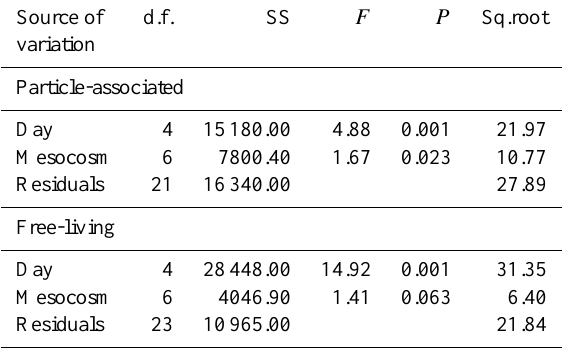
Table 2. Permutational multivariate analysis of variance (PER- MANOVA) on ARISA banding pattern (Bray–Curtis) of particle- associated and free-living bacteria resolving differences between experimental days and mesocosms. F is a multivariate analogue to Fisher’s F ratio (Anderson,